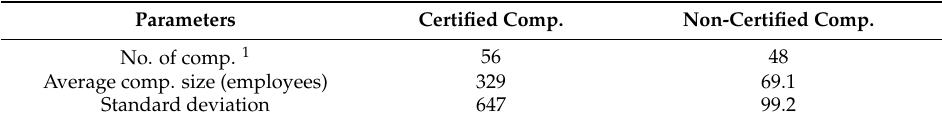
Table 2. Summary statistics over the samples of certified and non-certified companies